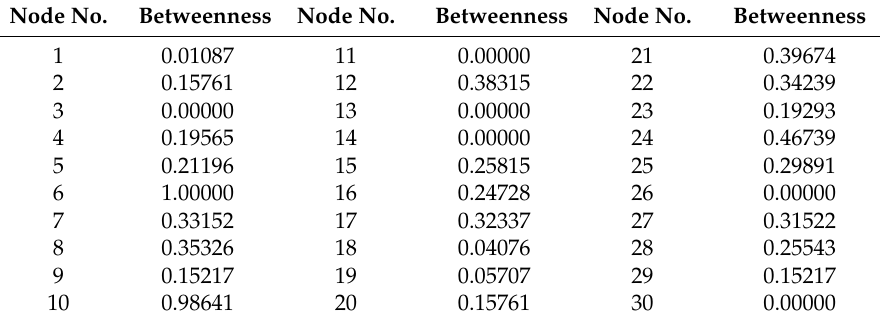
Table 4. Normalized node betweenness value of 30-bus microgrids. Node No. Betweenness Node No. Betweenness Node